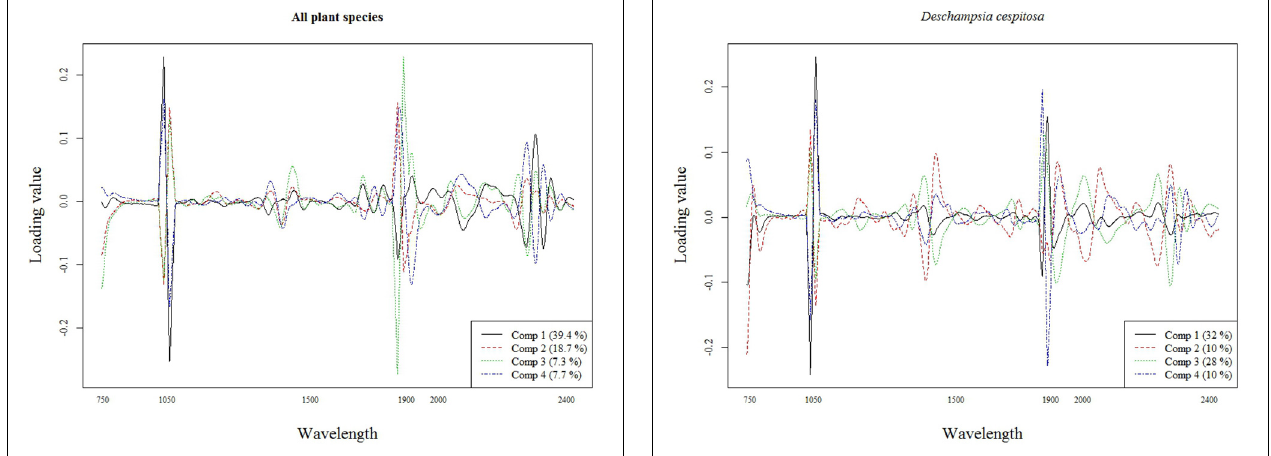
FIGURE 2 | Loading plot for the most important components of the calibration model for all plant species.